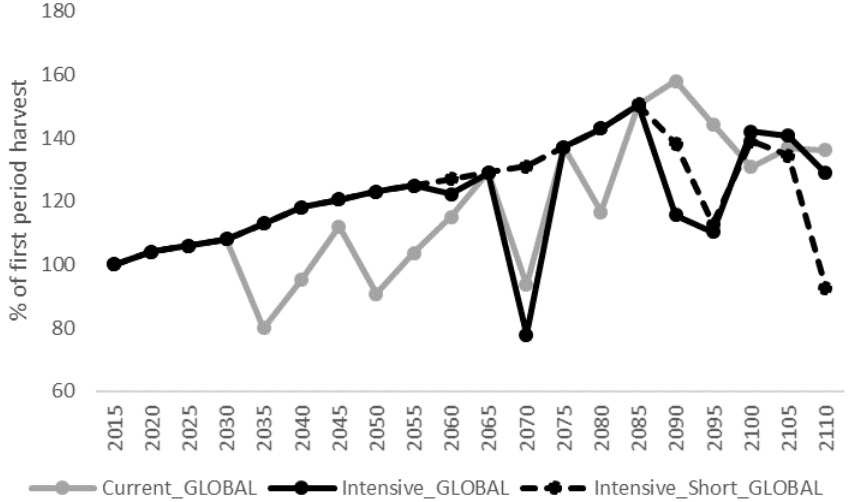
Figure 8. Projected harvests (expressed as percentage of first period harvest) of roundwood (sawlogs and pulpwood from thinning and final felling) with current management approaches of different intensities in the GLOBAL BIOENERGY scenario.